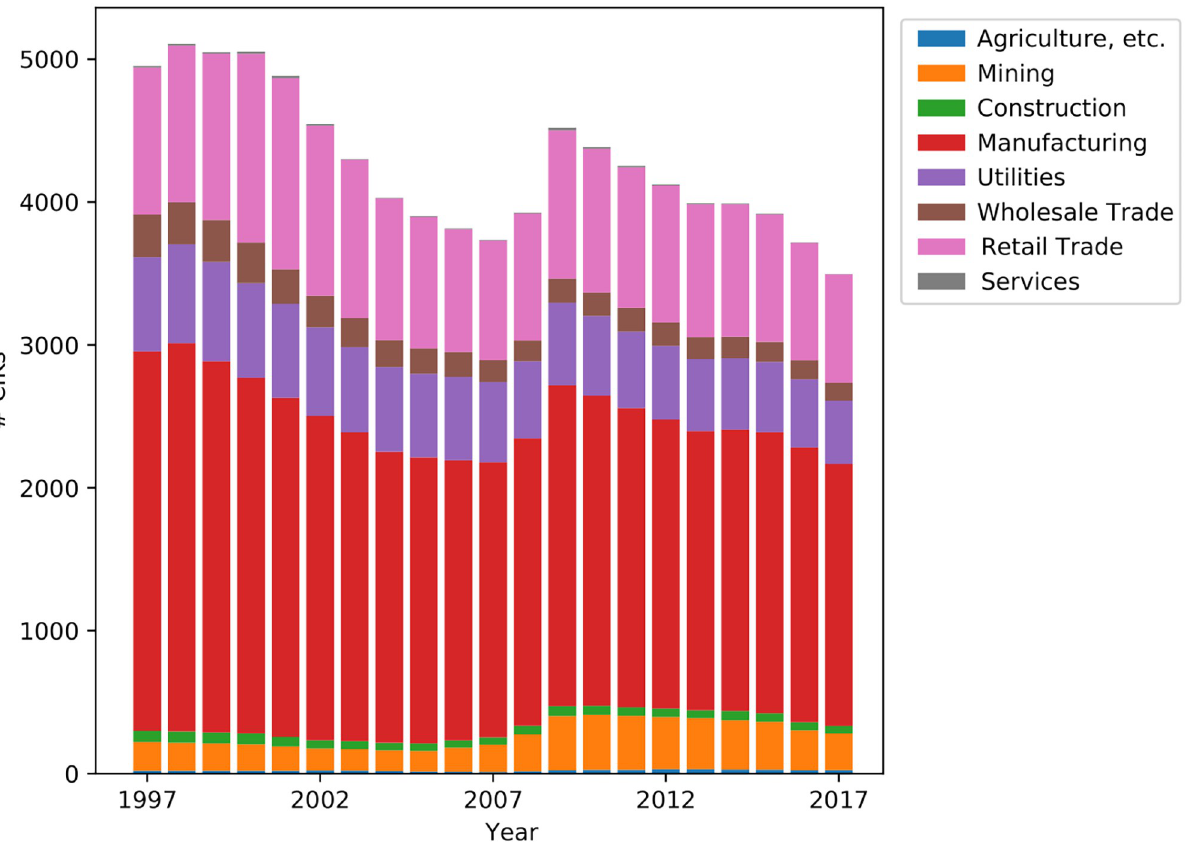
Fig 3. Annual count of 10-K documents in the training corpus; colors indicate SIC Divisions.